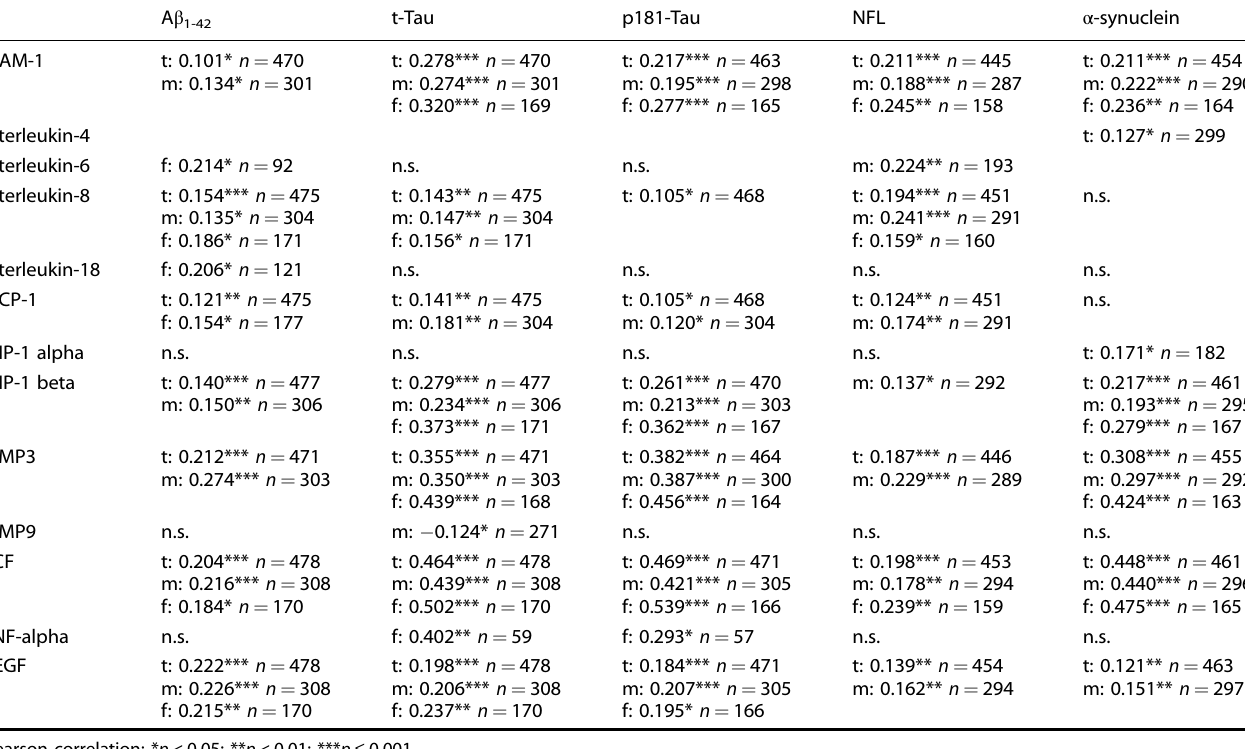
Table 3. Correlation between CSF in fl ammatory markers with CSF PD-biomarkers in people with Parkinson´s disease. A β 1-42 t-Tau